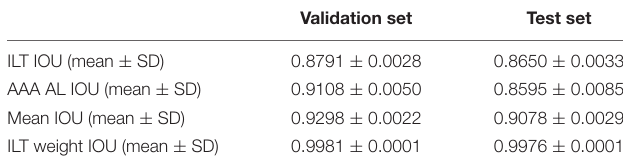
TABLE 3 | The segmentation performance in the validation set and test set. Validation set